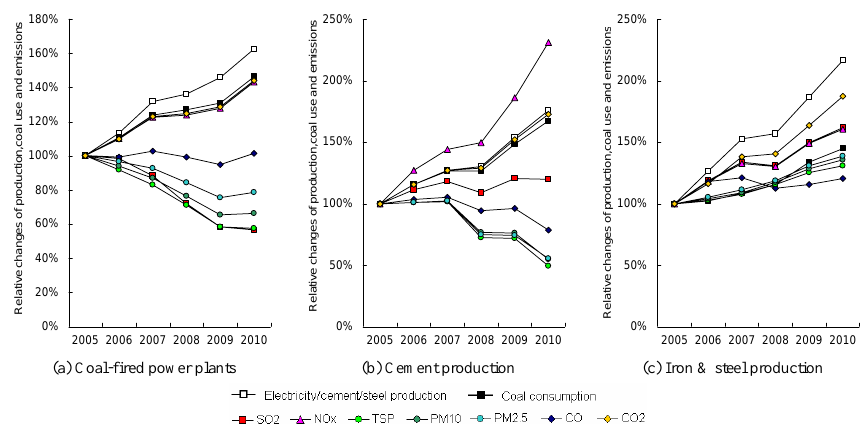
Fig. 6. Relative changes of production, coal consumption and emissions for coal-fired power plants (a) , cement plants (b) and iron and steel plants (c) from 2005 to 2010. Note the scales are different for the three